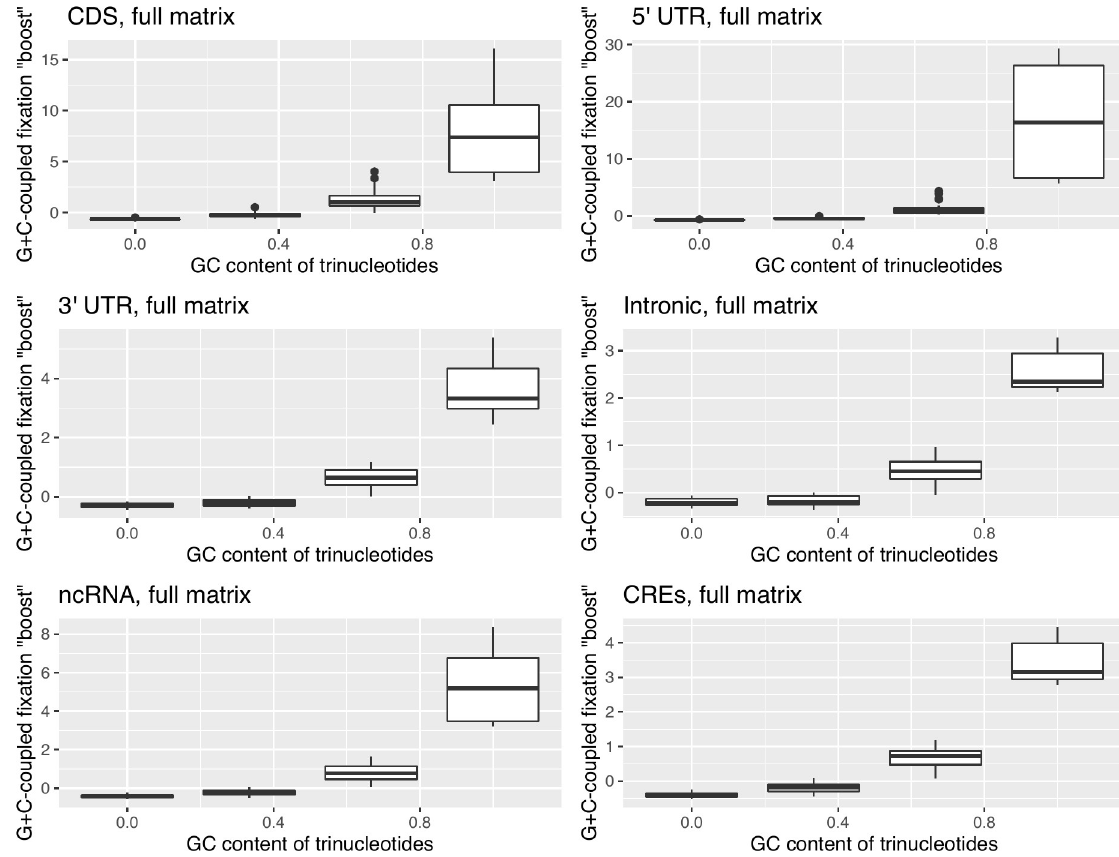
Fig 7. Deviation scores, (O-E)/E, describing the difference in GC-coupled fixation “boost” for the 4 GC classes of trinucleotides. Deviation between fixed and mutational equilibrium frequencies for each trinucleotide in the top 20% of sequences by GC content, D1, was calculated as (O-E)/E, where expected is the mutational equilibrium frequency. This was repeated for the bottom 20% of sequences by GC content to receive D2. As we predict GC-rich sequences to be subjected to stronger biased gene conversion, we predict D1 > D2. To compare D1 and D2, we once again calculate (O-E)/E, which we dub the GC-coupled fixation “boost”. In all sequences, GC content is positively correlated with this “boost” metric (Spearman’s rank; all p < 2.2 × 10 –16 ; rho = 0.92 in CDS, rho = 0.94 in 5 0 UTR, rho = 0.90 in 3 0 UTR, rho = 0.87 in introns, rho = 0.92 in ncRNA, rho = 0.93 in CREs, n = 64 in all tests). Underlying data can be found in S7 Data. CDS, coding sequence; CRE, cis -regulatory element; ncRNA, noncoding RNA; (O-E)/E,